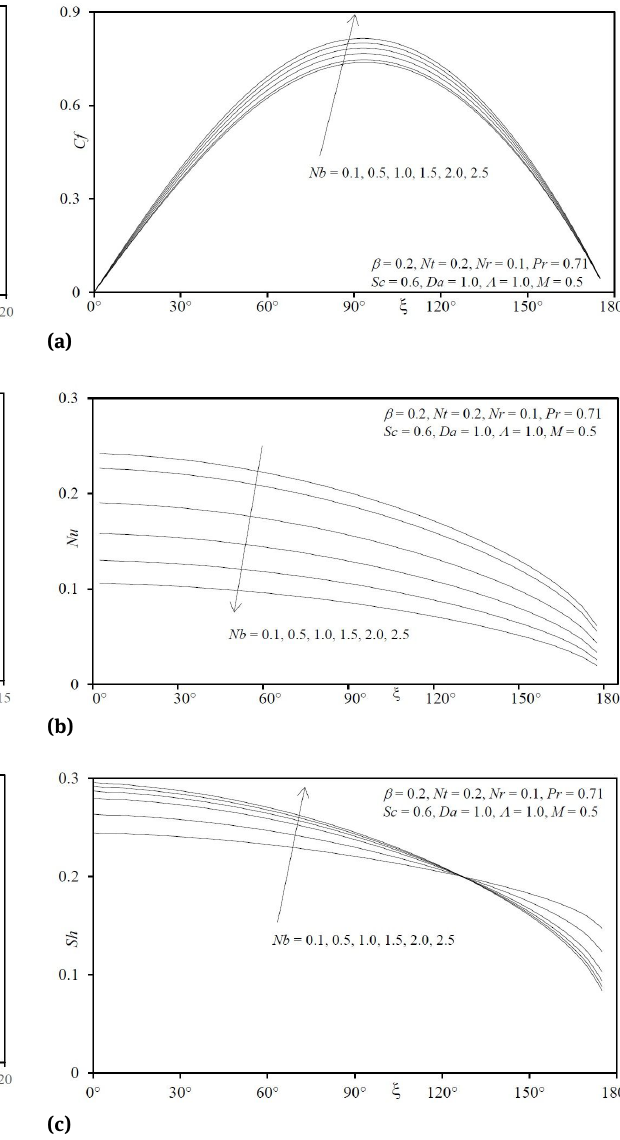
Fig. 8: (a) Influence of M on Velocity Profiles; (b) Influence of M on Temperature Profiles; (c) Influence of M on Concentration Profiles tion in the term ( sinξ /ξ) (θ - Nrφ) and couples the momen- tum equation to the thermal and concentration boundary layer equations respectively. With increasing Nr values, the velocity is decreased throughout the boundary layer.